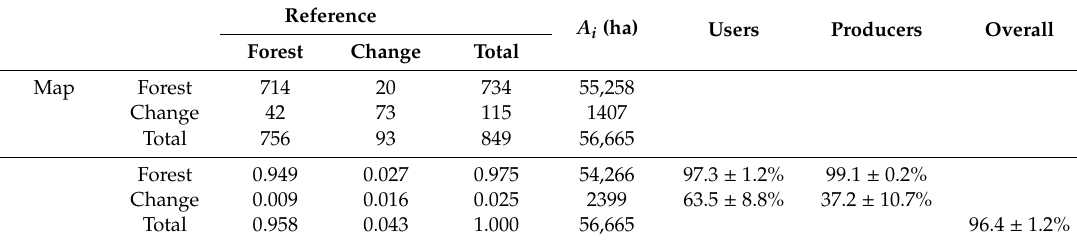
Table 3. Error matrix for Malawi, blind approach—1 orbit.